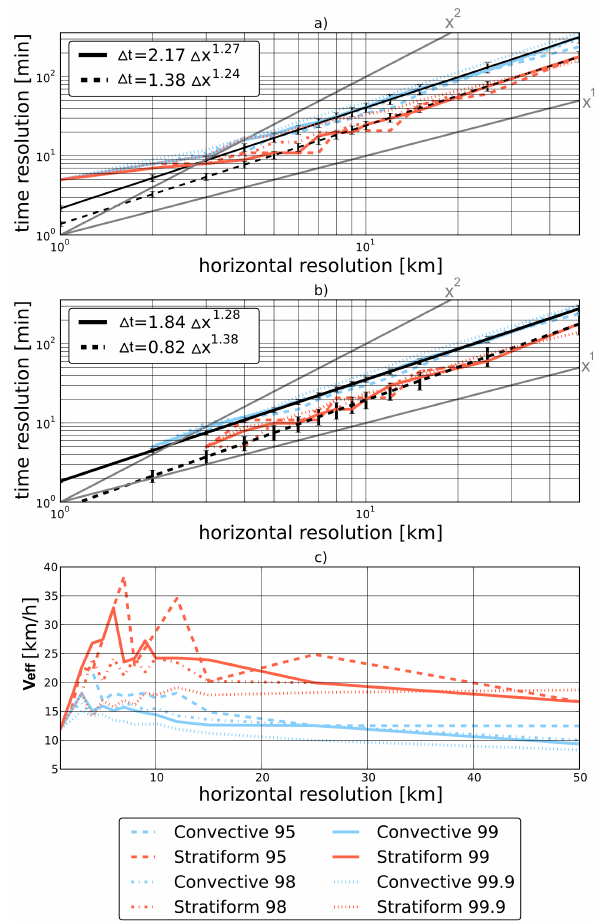
Figure 7. Consistent spatial and temporal resolutions. (cid:49)t derived using Eq. (5) for different values of (cid:49)x for convective (blue) and stratiform (red) precipitation extremes at the 95th, 98th, 99th and 99.9th percentiles. Black lines are least square fit of (cid:49)t = a × (cid:49)x b with the fitting parameters a and b for the 99th percentile. Er- ror bars indicate the standard deviation of parameter estimates.